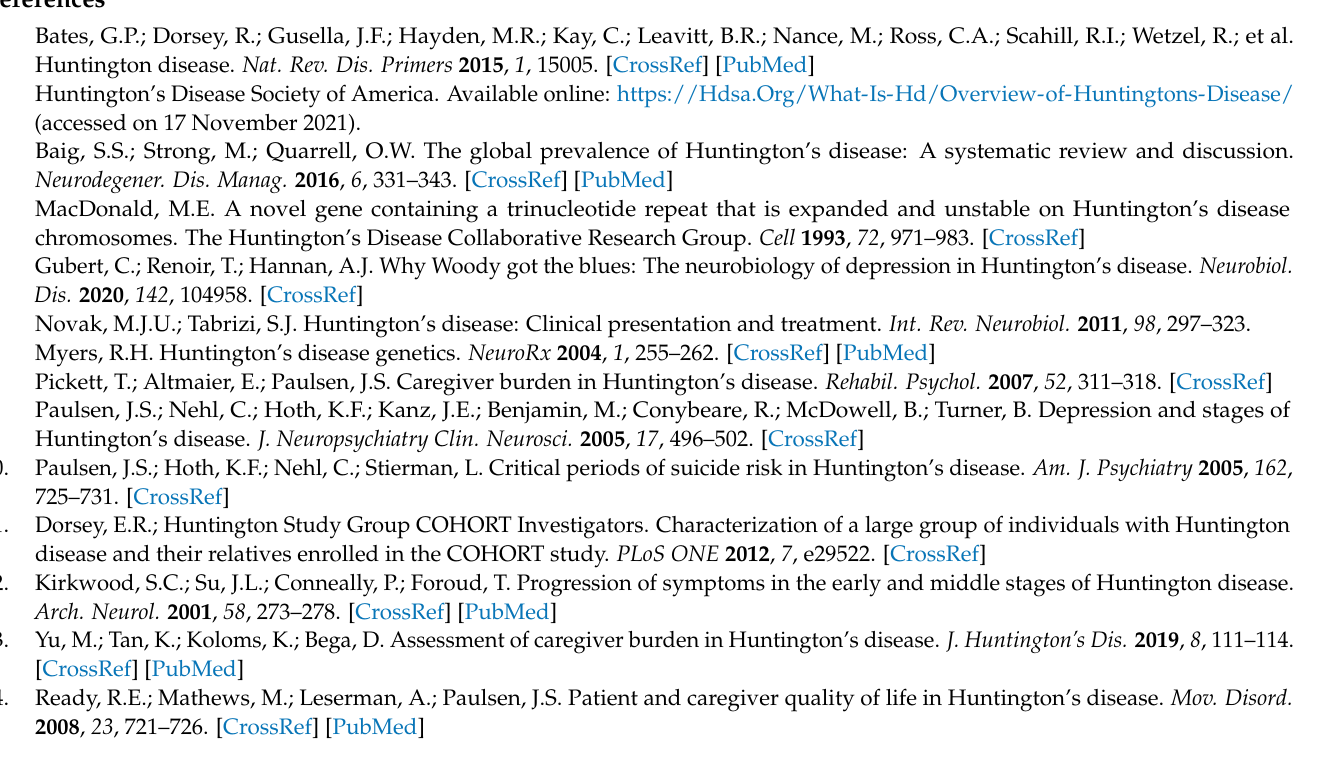
Table S2: Impact of HD on patients; Table S3: Impact of HD on care